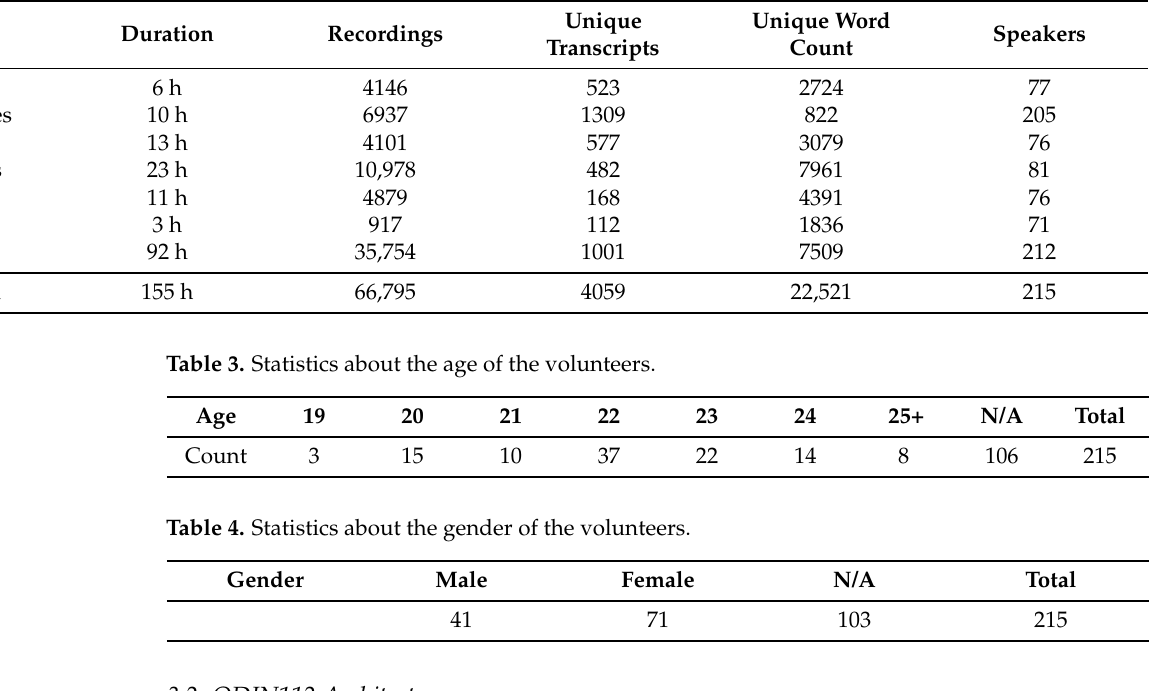
Table 2. Subsets of the collected speech corpora for the Romanian language.